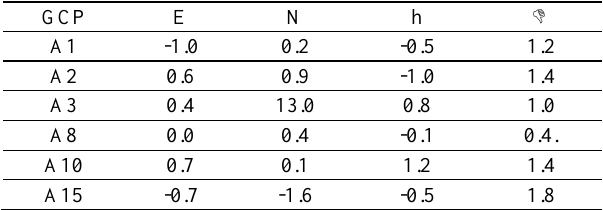
Table 4b. Georeferencing residuals on GCPs measured in nRTK mode for TLS